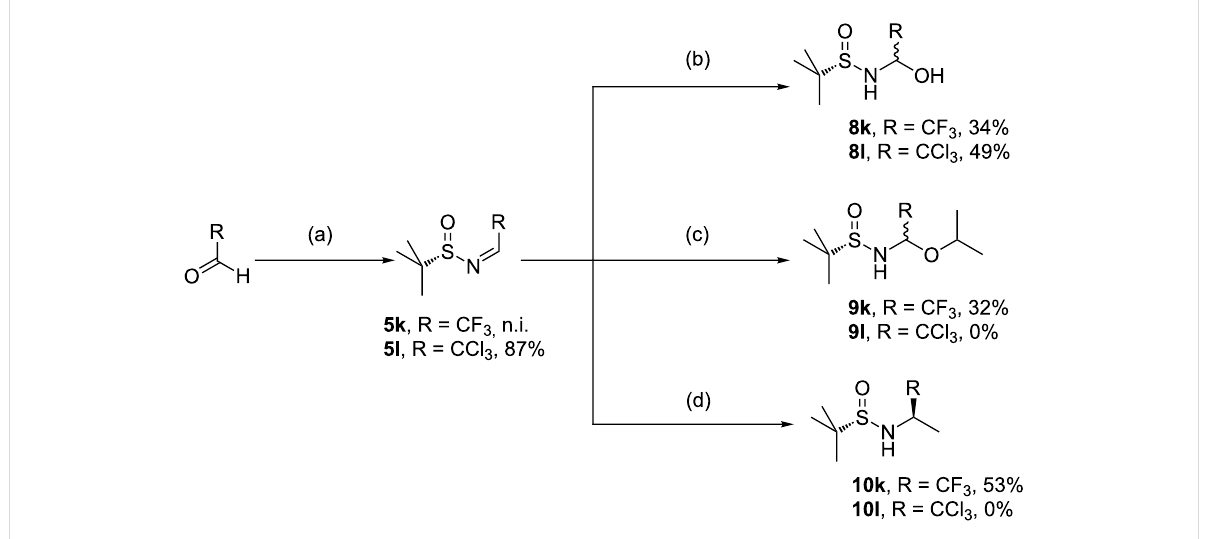
Figure 6: Side reactions observed in the course of the conversion of highly electrophilic sulfinylimines 5 . (a) Sulfinamide ( S )- 1 , molecular sieves 4 Å, toluene. (b) 1. Dilution with H 2 O, 2. Extraction with DCM. (c) Addition of Ti(OiPr) 4 prior to the conversion with (trimethylslyl)ethynyllithium [94]. (d) Ad- dition of AlMe 3 prior to the conversion with (trimethylsilyl)ethynyllithium.